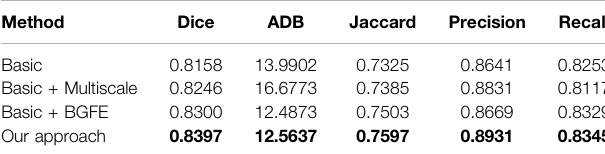
TABLE 3 | Measurement results of different baseline networks on the BUSZPH dataset. Our results are highlighted in bold. Method